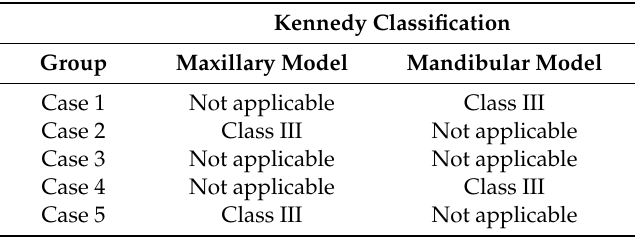
Table 1. Classification of plaster dental models used for